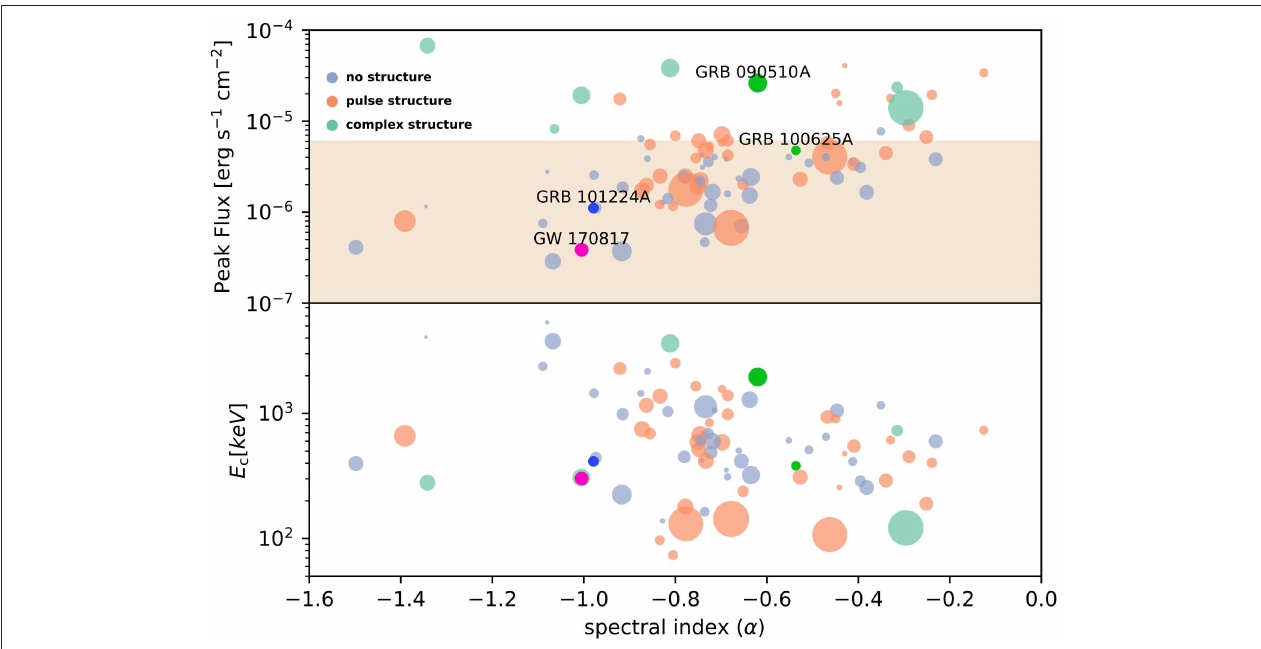
FIGURE 2 | Comparison of the spectral properties of GRB 170817A and the spectrally and temporally similar GRB 101224A with respect to our sample of well-fit short GRBs. Colors indicate light curve structure (see labels in the top left) and size indicates the duration from our Bayesian block analysis. The shaded region corresponds to the flux level at which off-axis short GRBs become the dominant contribution to the total rate (see Figure 5 ).